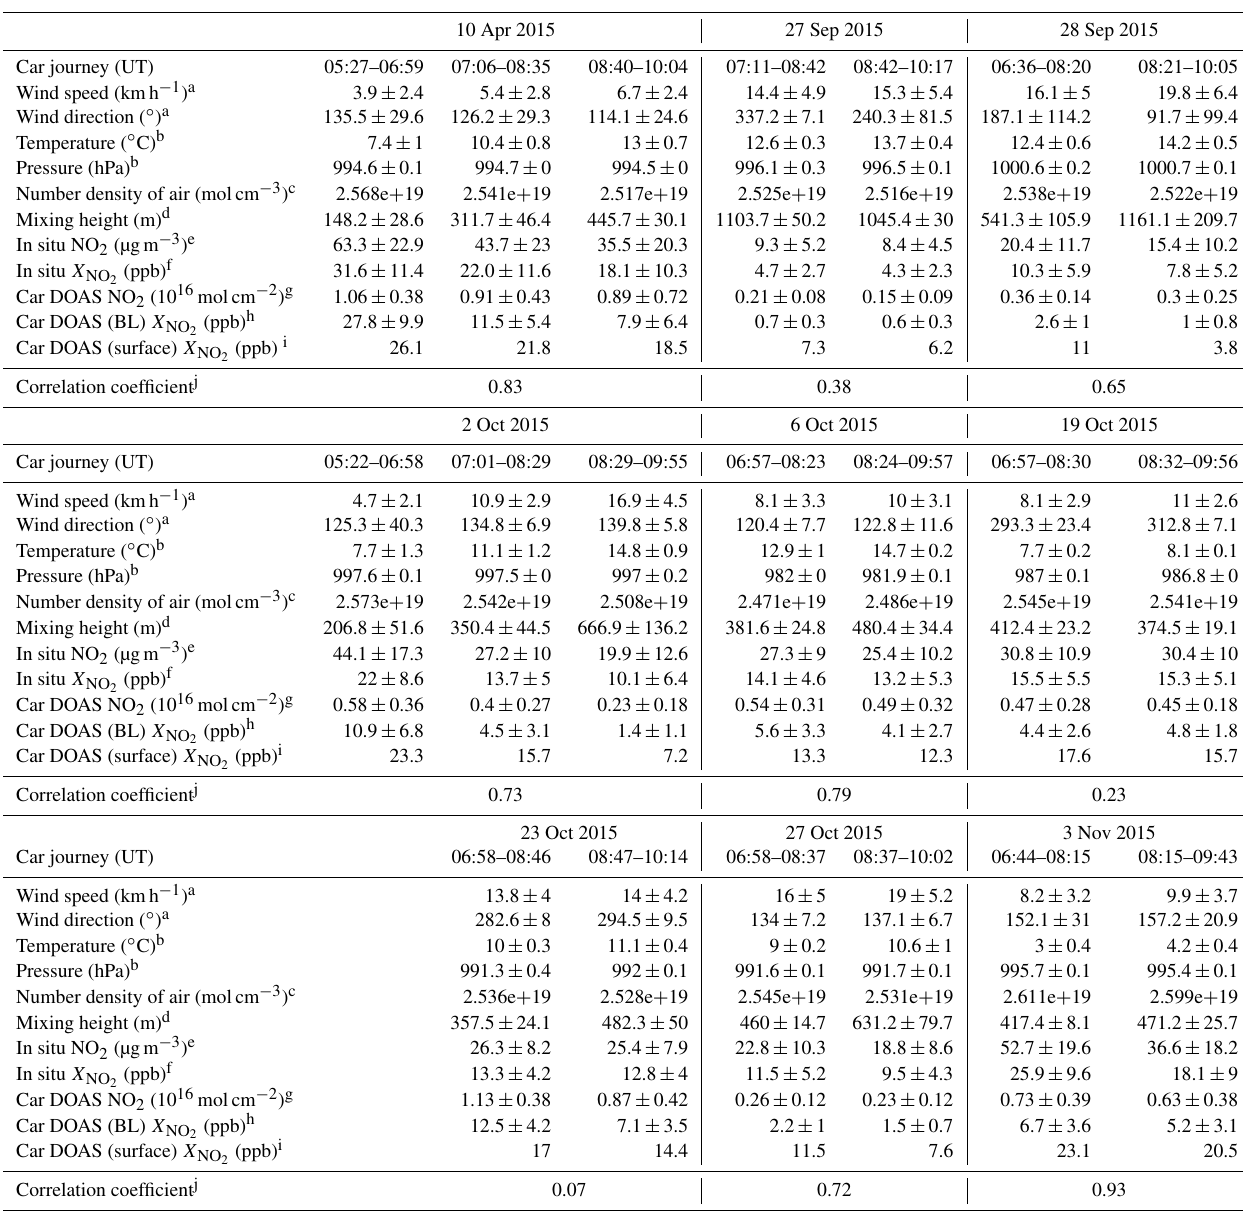
Table 3. Summary of statistics of the individual car journeys including lap averages of wind speed, wind direction, temperature, pressure, number density of air, mixing height, in situ NO 2 from selected air quality monitoring stations, and NO 2 VCD tropo from car DOAS mea- surements. Converted averaged NO 2 mixing ratios based on two different equations are also given. The correlation coefficients (R) obtained from the linear relationship between car DOAS and in situ NO 2 are also shown (further details are given in the